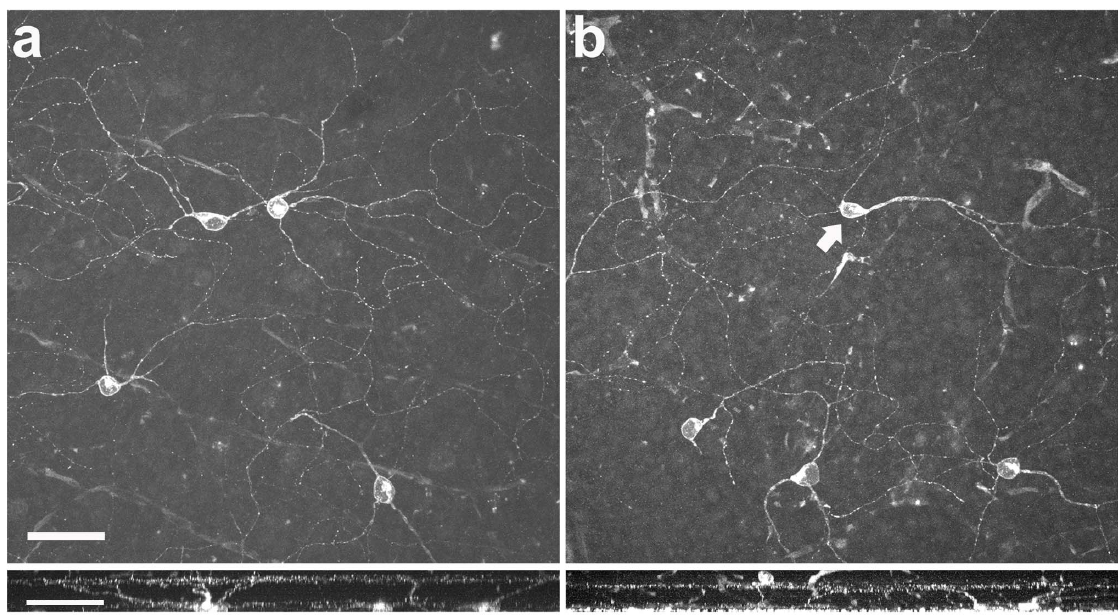
Figure 4. Morphological comparison of M1 ganglion cells in normal and optic nerve transected retina. (a) M1 ganglion cell immunostaining in the control eye. Bottom panel shows a side view with the typical stratification in the OFF sublamina of the inner plexiform layer. (b) M1 ganglion cell immunostaining 60 days after optic nerve transection. A displaced M1 ganglion cell is included (arrow). Bottom panel shows that in the injured retina the M1 ganglion cell dendrites remain in the same lamina of the IPL as in the control retina. Scale bar=50 m m.